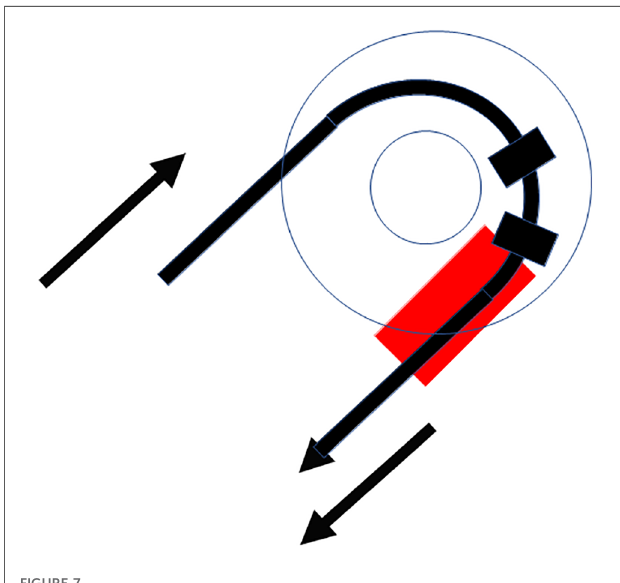
FIGURE 7 Schematic moving the tumor (red) out of the